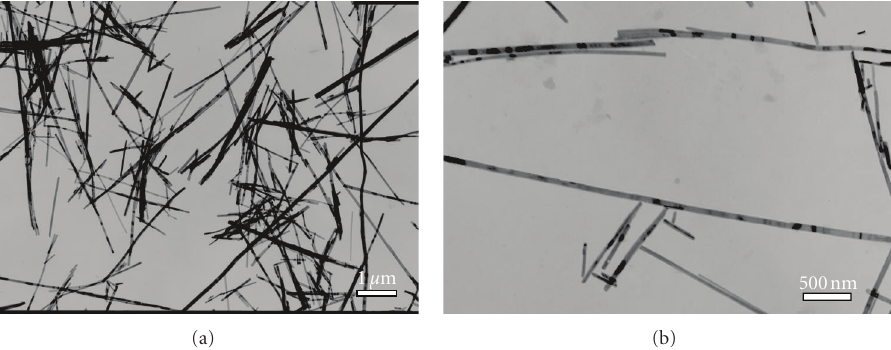
Figure 3: (a) TEM image of the composite Bi 2 O 3 -Bi 2 CrO 6 nanowires; (b) a TEM image of a typical nanowire junction.